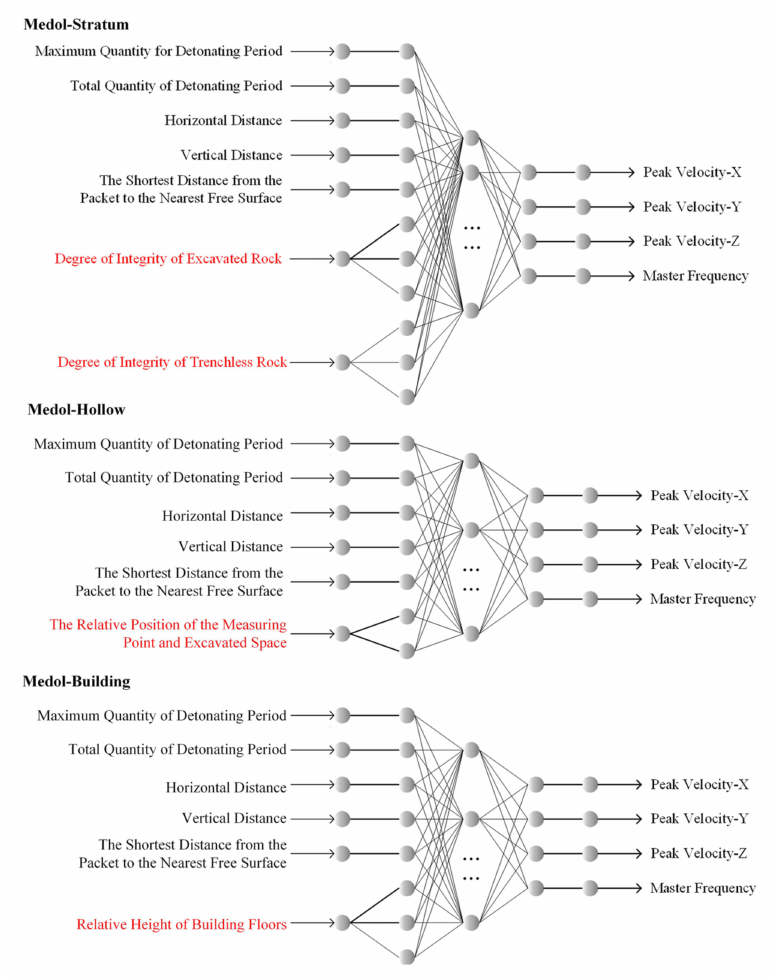
Figure 2. The topology of fuzzy neural network in different